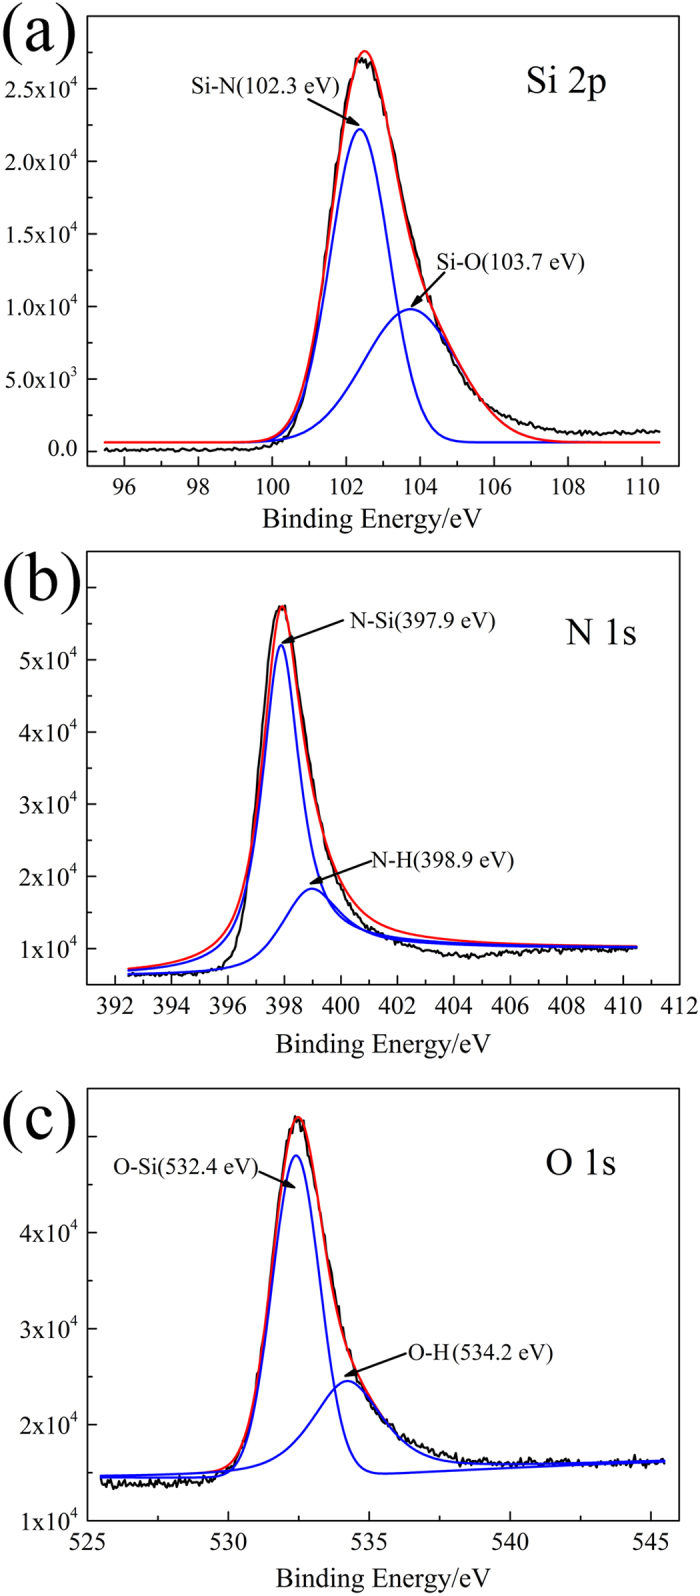
XPS spectra of the as-synthesized α-Si3N4 nanowires: (a) Si 2p; (b) N 1s; (c) O 1s.